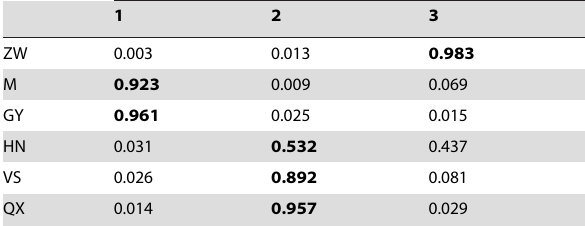
Clusters with the highest membership coefficient are in bold, and clusters with a membership coefficient over 0.1 for given sampling sites are underlined. See Table 1 for sample site abbreviations.